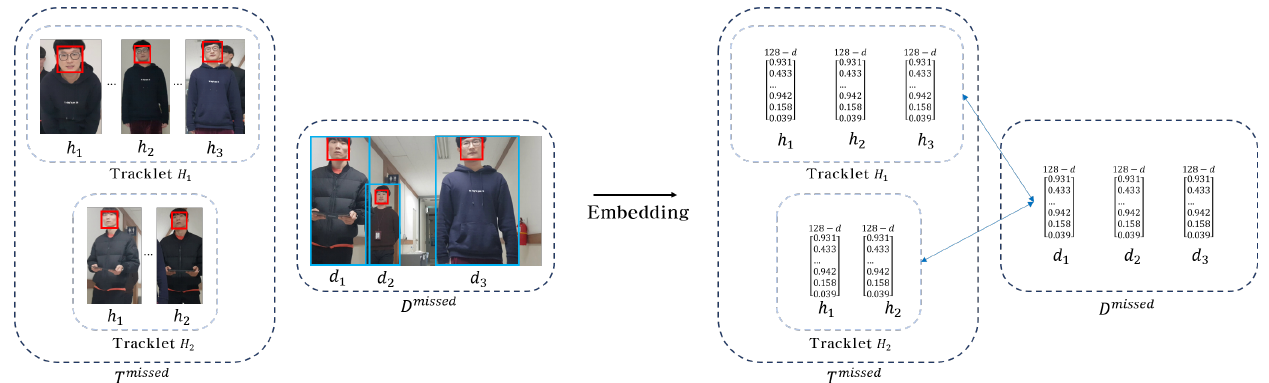
Figure 4. Schematic representation of the proposed face appearance